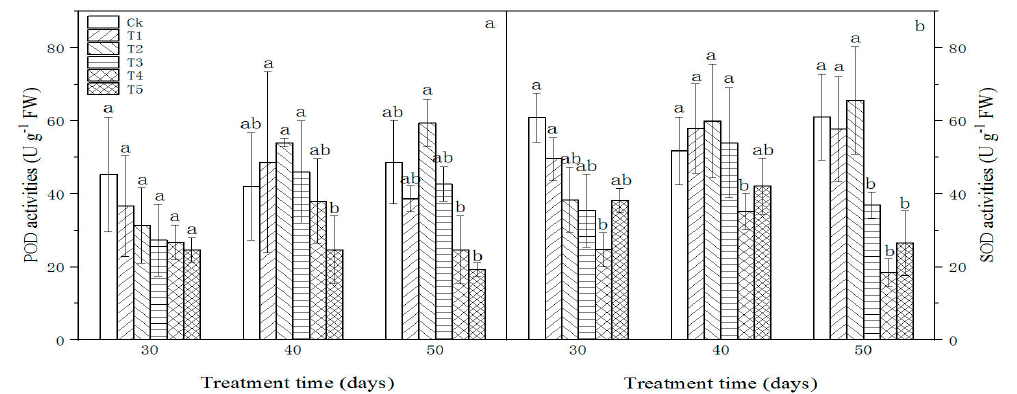
Figure 6. Peroxide (POD, a ) and superoxide dismutase (SOD, b ) activities of L. olgensis leaves treated with different concentrations of graphene at three sampling times (mean ± 1 S.D., n =3). FW = fresh mass. Values followed by the same letter for the same days are not significantly different at p < 0.05. Ck, T1, T2, T3, T4 and T5 represent 0, 25, 50, 100, 250, and 500 mg L -1 graphene treatments, respectively.